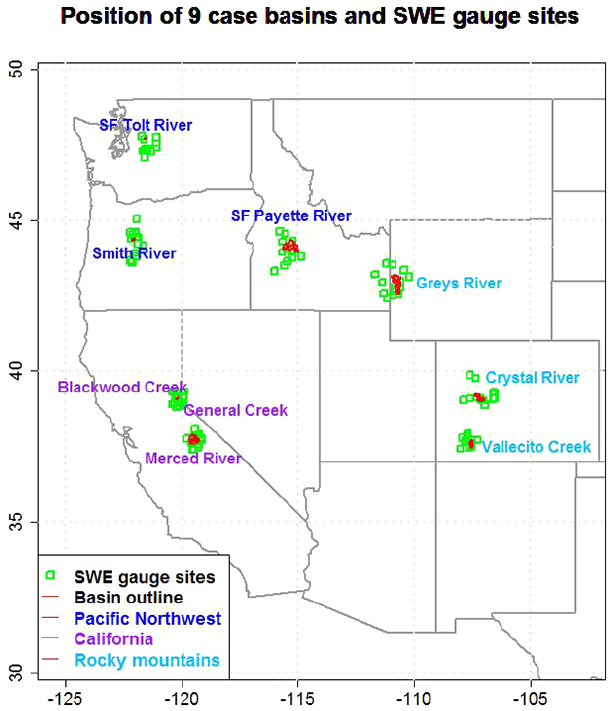
Figure 1. Location of nine case basins in the western United States (US) and SWE gauge